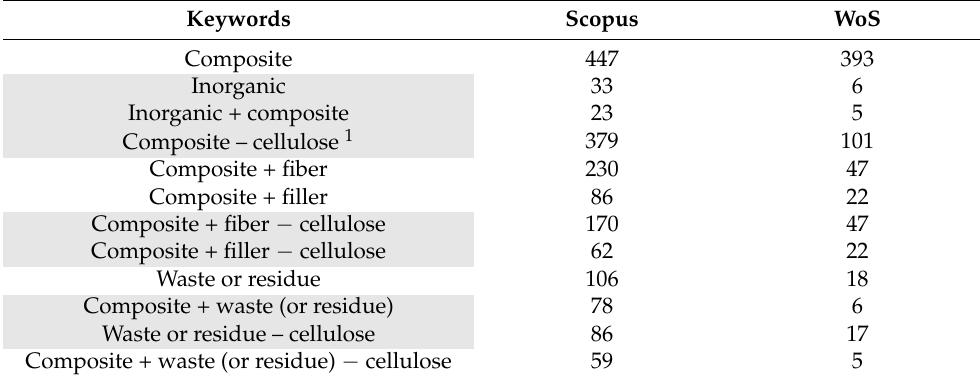
Table 1. Number of papers found from Scopus and WoS